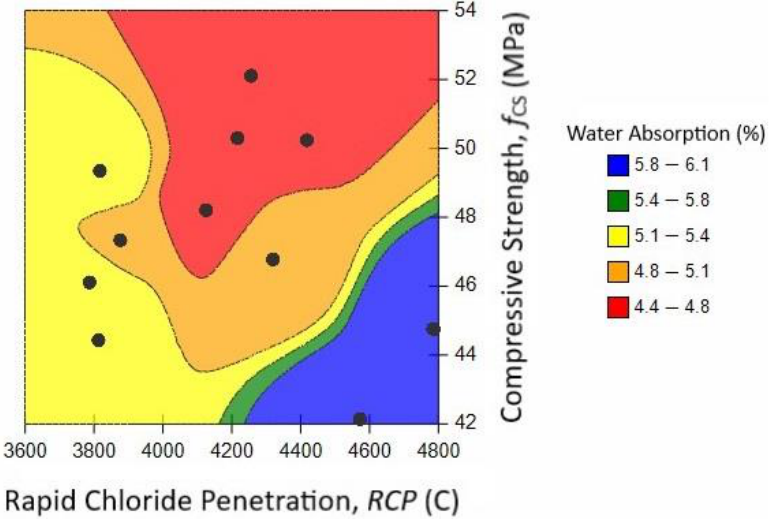
Figure 22. Relationship between RCP, f CS , and WA .